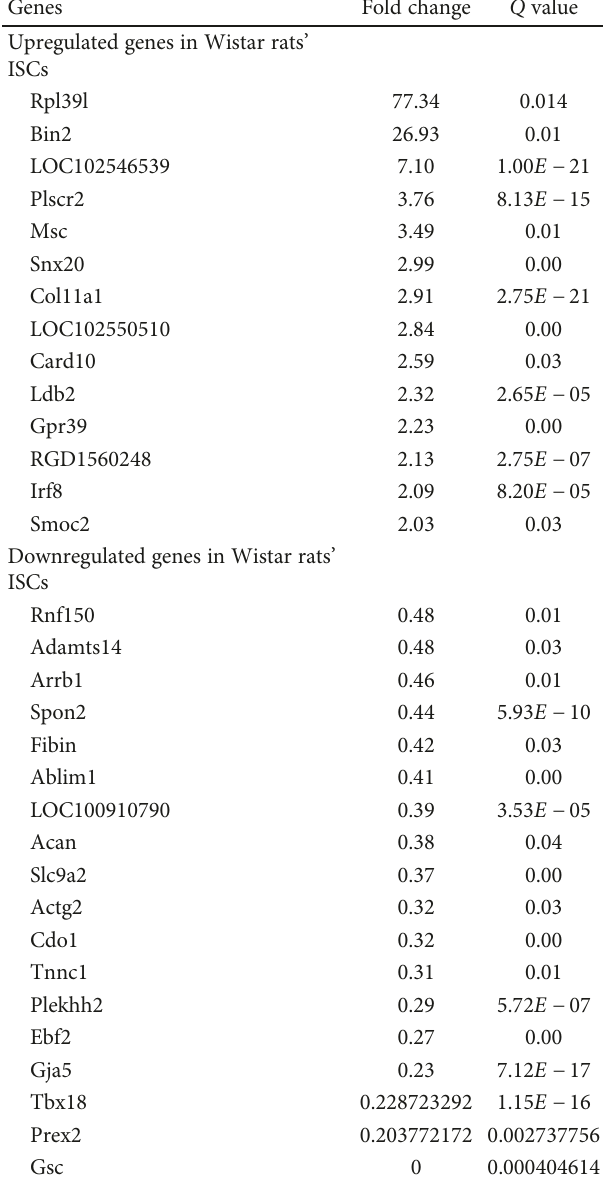
Table 2: The signi fi cant di ff erentially expressed genes between PSCs and